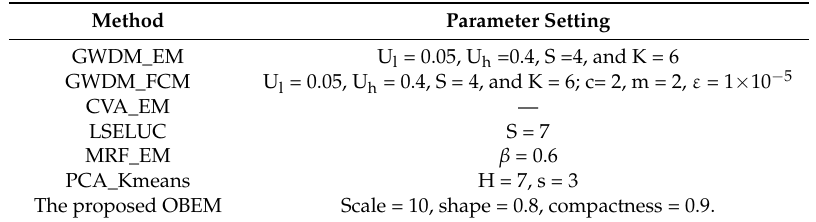
Table 2. Parameter settings of different LCCD methods for the third and fourth data